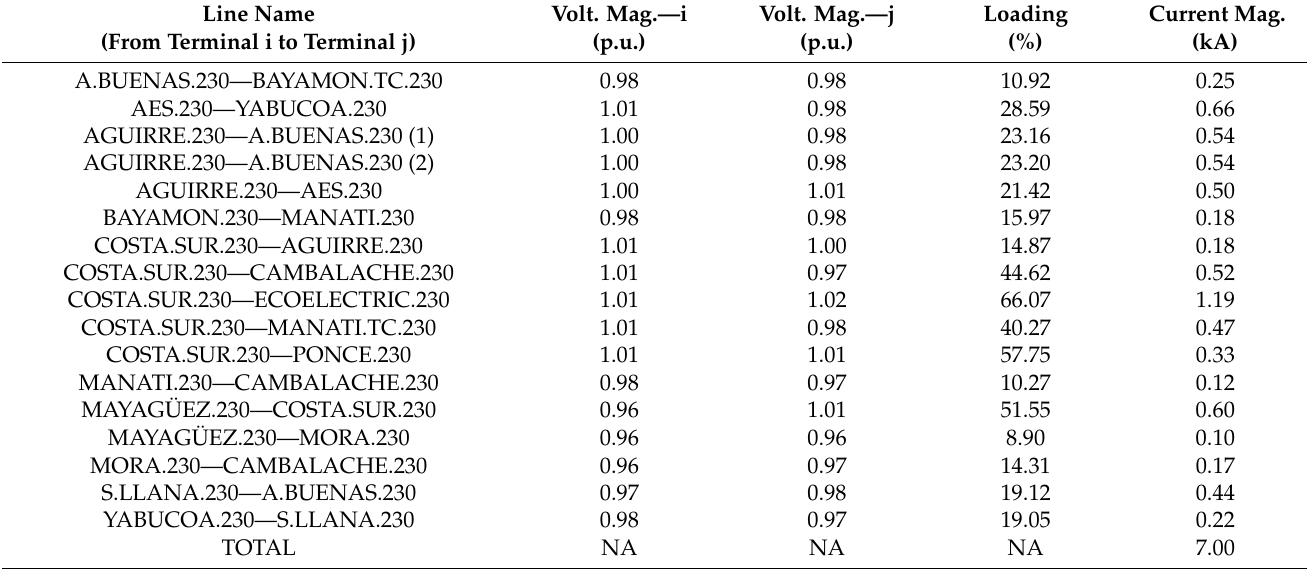
Table 13. Power flow in 230-kV lines at 12 p.m. for the base scenario.